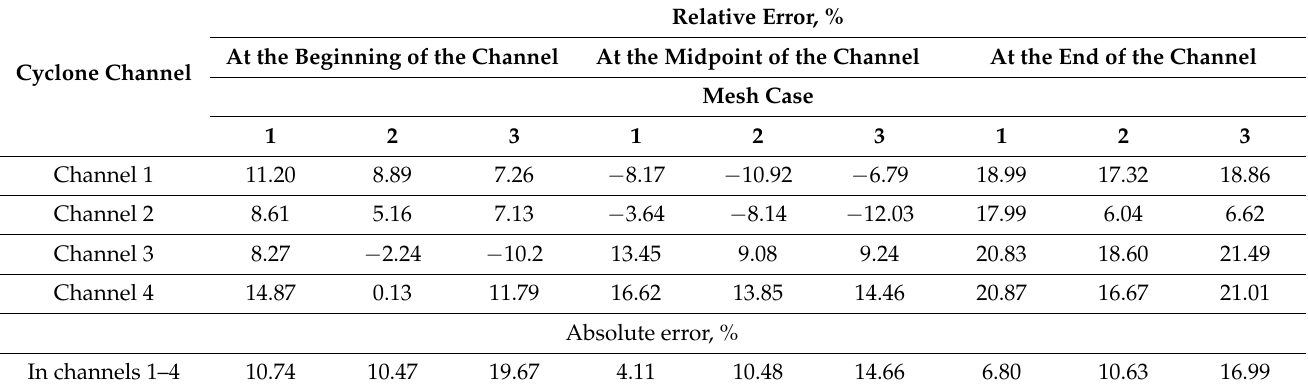
Table 2. The relative errors of the gas flow rate values obtained in the symmetrical channels of the multi-channel cyclone separator with a single inlet in the experimental research and numerical simulation using k- ω SST viscosity model, using computational meshes with various degrees of detailed